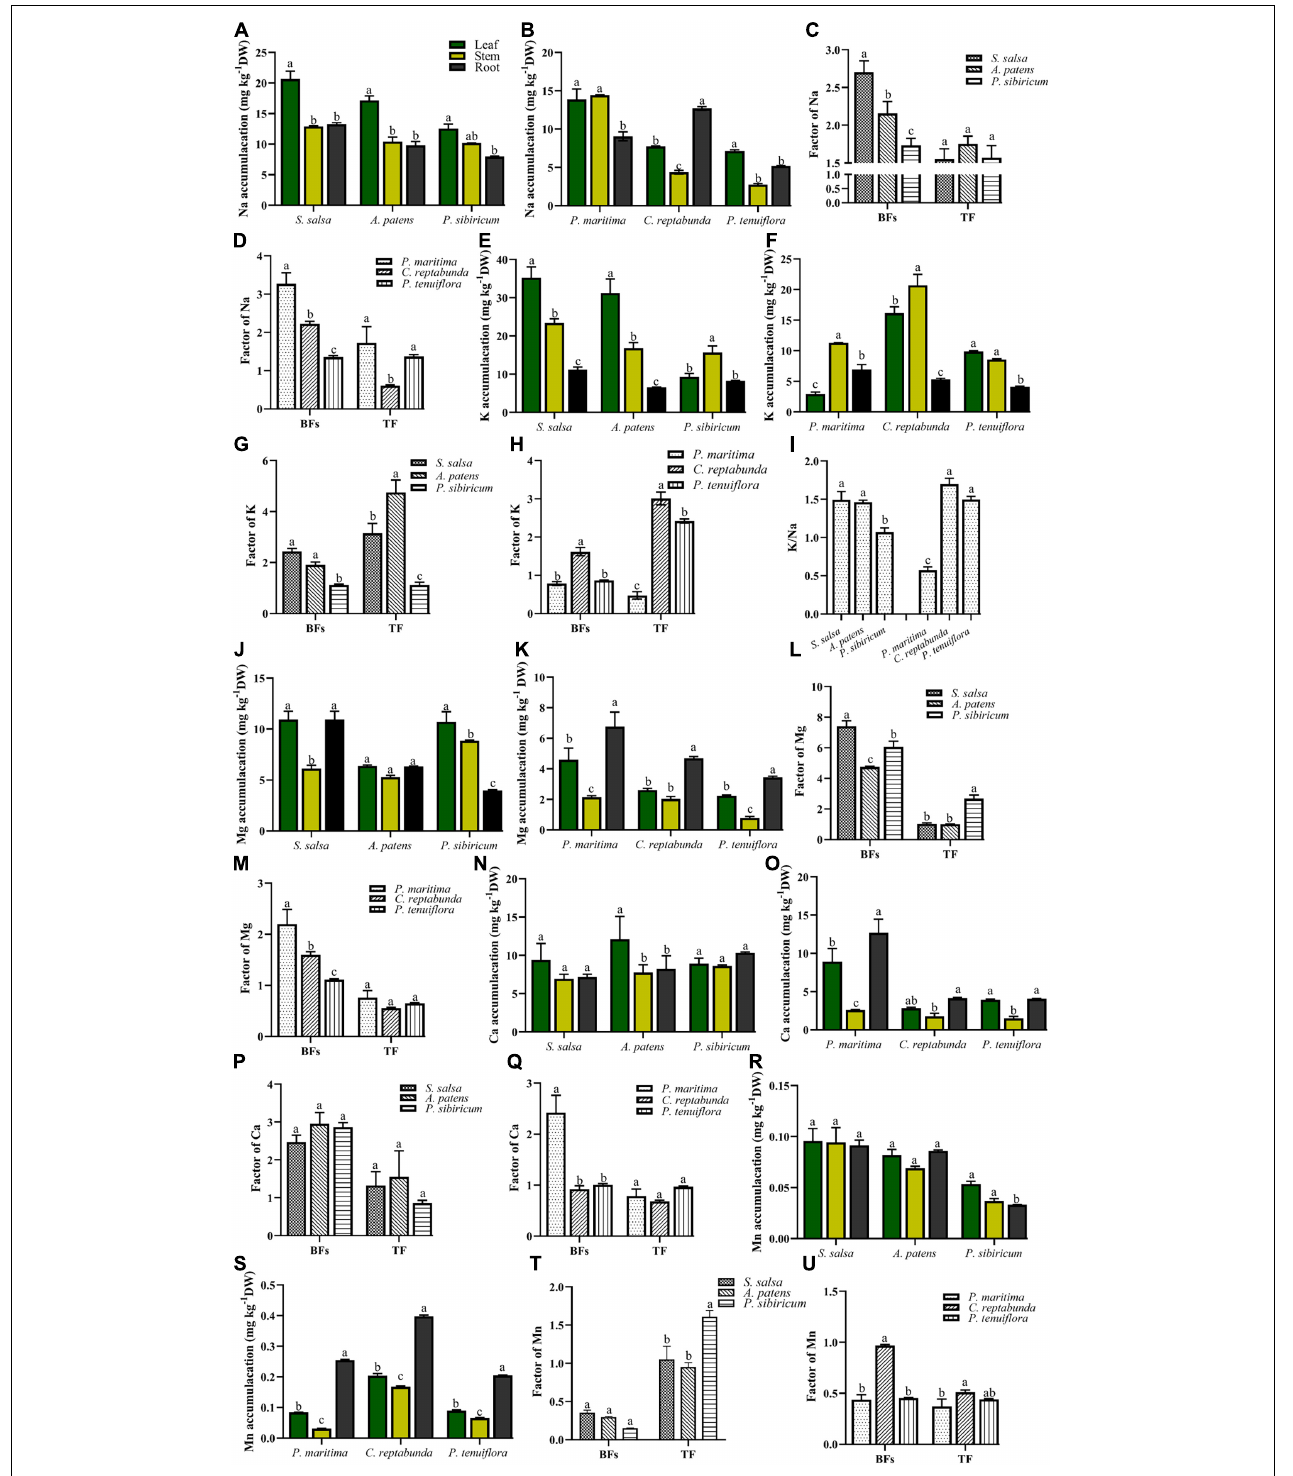
FIGURE 3 | The accumulation of significantly different elements in various kinds of plants in S. salsa community and P. tenuiflora community: (A,E,J,N,R) Na, K, Mg, Ca, Mn accumulation in S. salsa community, respectively; (B,F,K,O,S) Na, K, Mg, Ca, Mn accumulation in P. tenuiflora community, respectively; (C,G,L,P,T) the BFs and TF of Na, K, Mg, Ca, Mn in S. salsa community, respectively; (D,H,M,Q,U) the BFs and TF of Na, K, Mg, Ca, Mn in P. tenuiflora community, respectively. (I) The ratio of Na and K; The accumulation of significantly different elements is summarized from three biological replicates and presented as the mean ± standard error. Different letters indicate significant differences among treatments ( p <